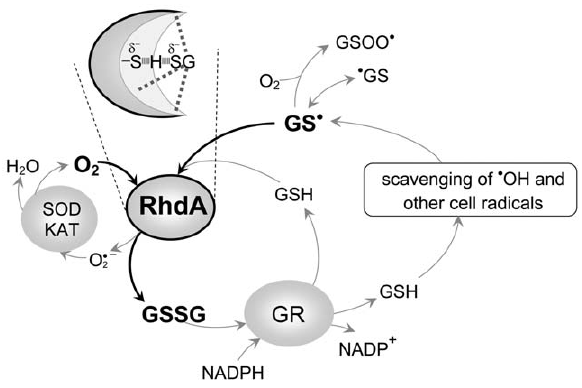
Figure 8. Role of RhdA in GS N -scavenging. The scheme displays a possible interplay of RhdA-catalyzed GS N -scavenging (thick lines) with other players (grey lines) involved in GSH homeostasis. The oxygen- dependent GS N -scavenging activity of RhdA would allow the dissipation of GS N as disulfide glutathione (GSSG), and GSH is produced from GSSG by the glutathione reductase activity (GR). The superoxide anion can be removed by the generally recognized players in superoxide scavenging machinery (i.e. superoxide dismutase, SOD, and catalase, KAT). The inset depicts the likely feature of the RhdA active-site at the beginning of the GS N -scavenging reaction.